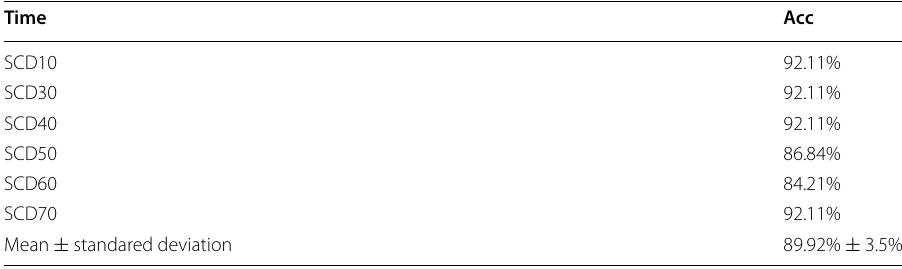
Table 5 Classification accuracy with selected segment of HRV for training and testing